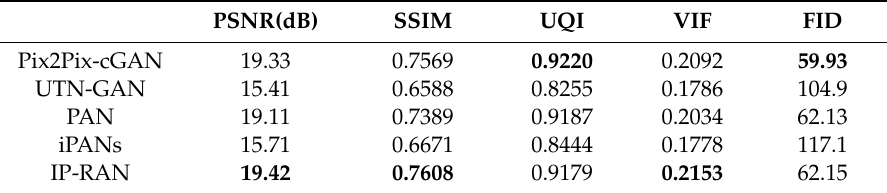
Figure 8. Samples result from edges to shoes. ( a ) input images, ( b ) results of the IP-RAN, ( c ) results of the pix2pix-cGAN, ( d ) results of PAN, ( e ) results of UTN-GAN, and ( f ) results of iPANs Table 5. Quantitative results of Edges to Shoes, bold results show good scores.